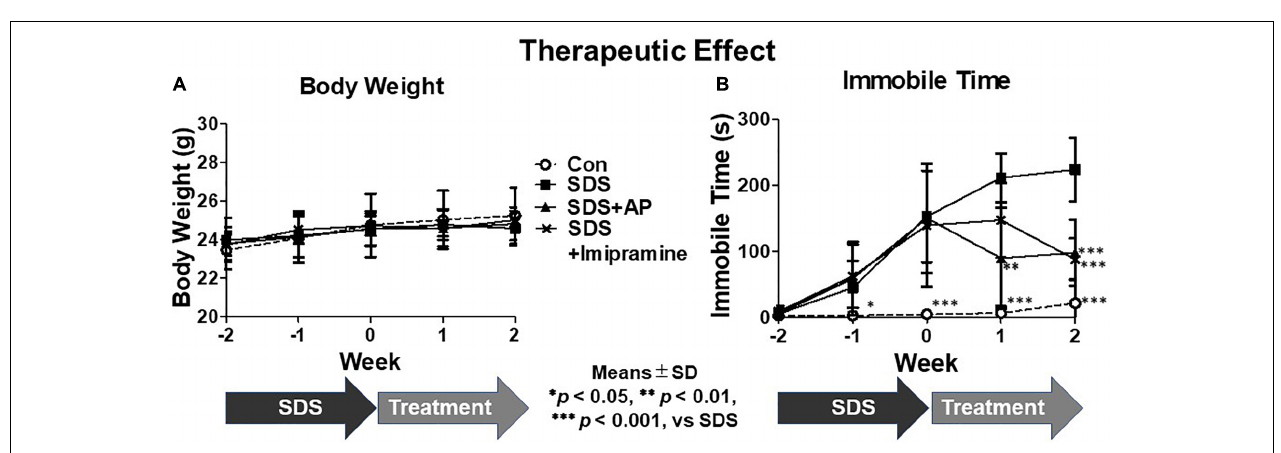
FIGURE 4 | The development of depression symptoms in mice induced by SDS were suppressed by acupuncture. (A) Weight changes and (B) immobile time in the forced swimming test in mice with SDS stress. Values are means ± SD ( n = 8). ∗ p < 0.05, ∗∗ p < 0.01, and ∗∗∗ p < 0.001 versus SDS group. AP, acupuncture; SD, standard deviation; SDS, social defeat stress.